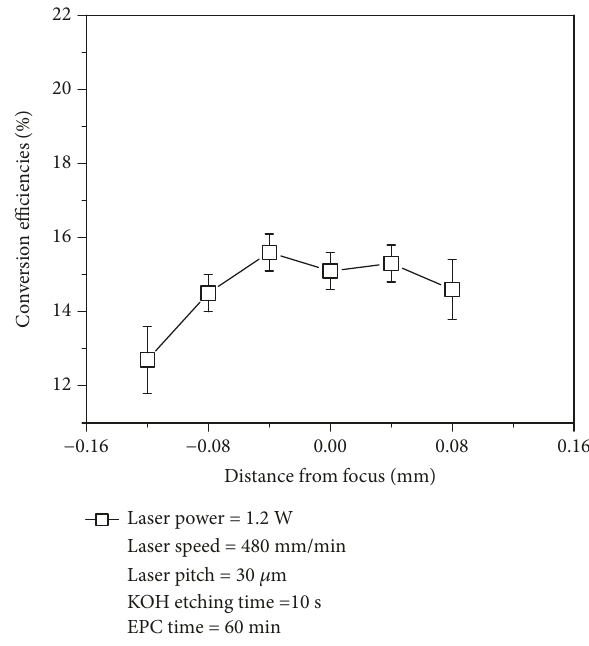
Figure 1: Conversion e ffi ciency vs. laser position curve of SPMSCs with a B-BSF seed layer and EPC contact layer as the rear